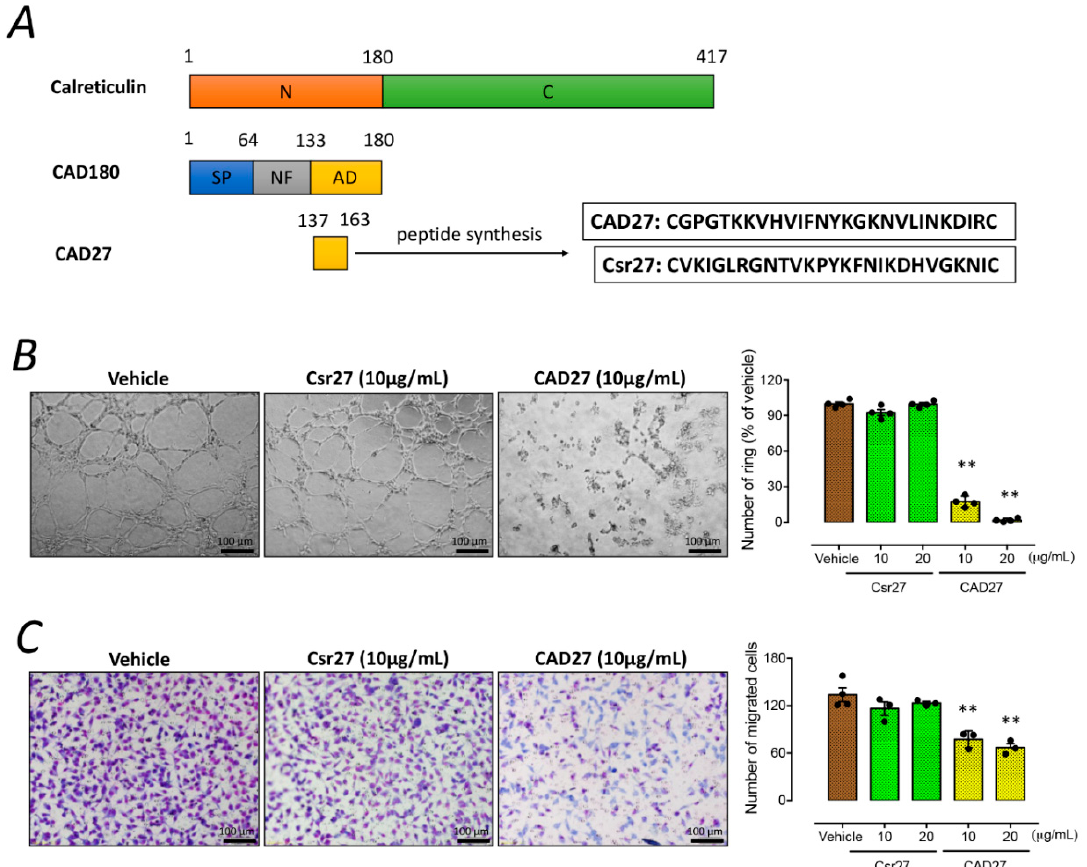
Figure 2. The effect of CAD27 on in vitro angiogenic activities. ( A ) Schematic representation of CAD27. CAD27 was derived from anti-angiogenic domain (residues 137–163) of calreticulin. N: N-terminal